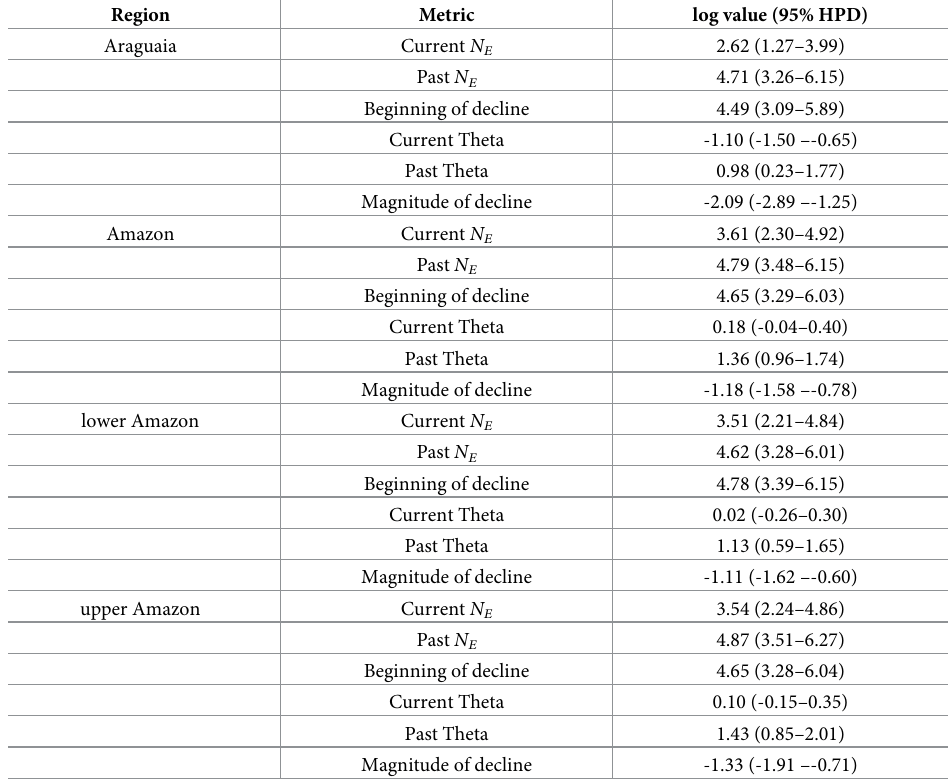
Table 5. Population decline coalescent metrics for Arapaima gigas by